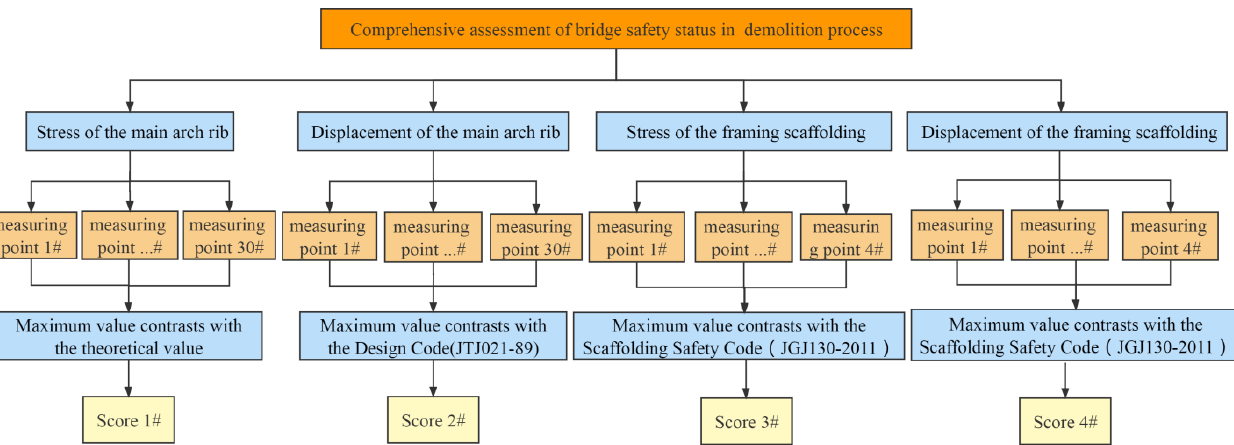
Figure 6. Hierarchical division of comprehensive assessment of bridge safety status in the demoli- tion process.